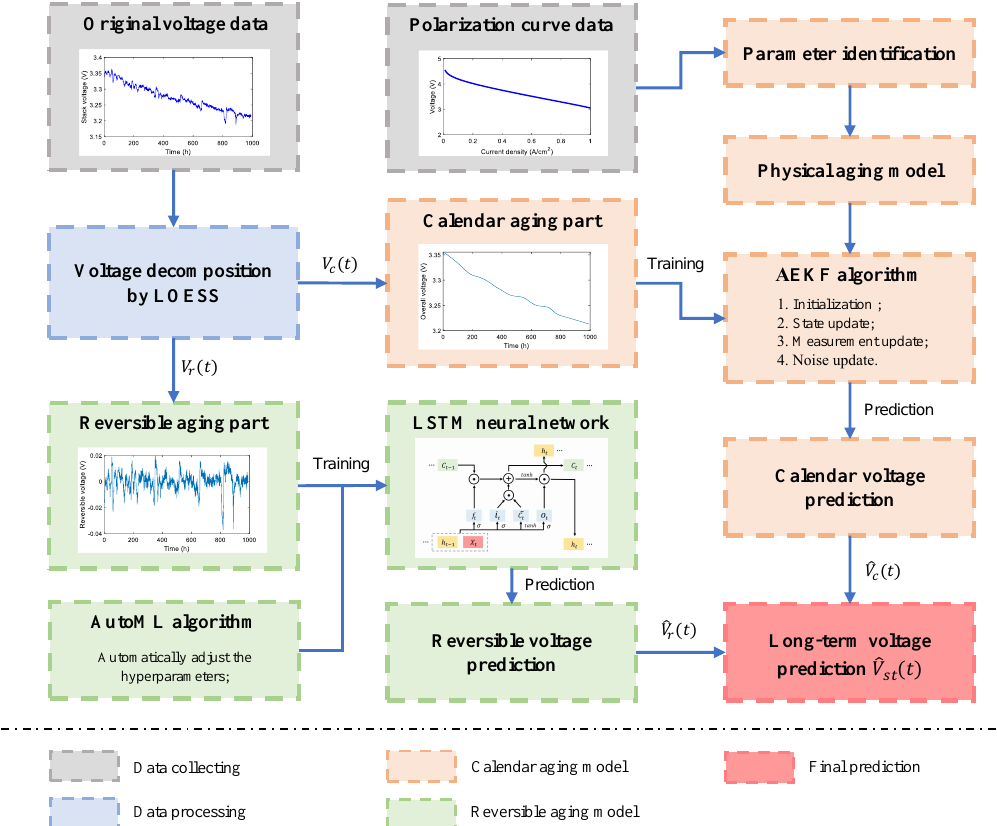
Figure 1. The decomposition forecasting framework of the proposed hybrid